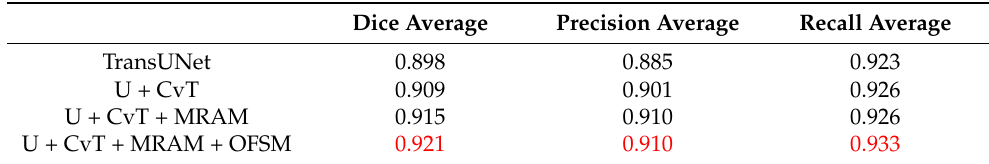
Table 1. Ablation analysis on ACDC for different components in the network. All methods were run 10 times to take the average. The best performance is shown in red. Dice